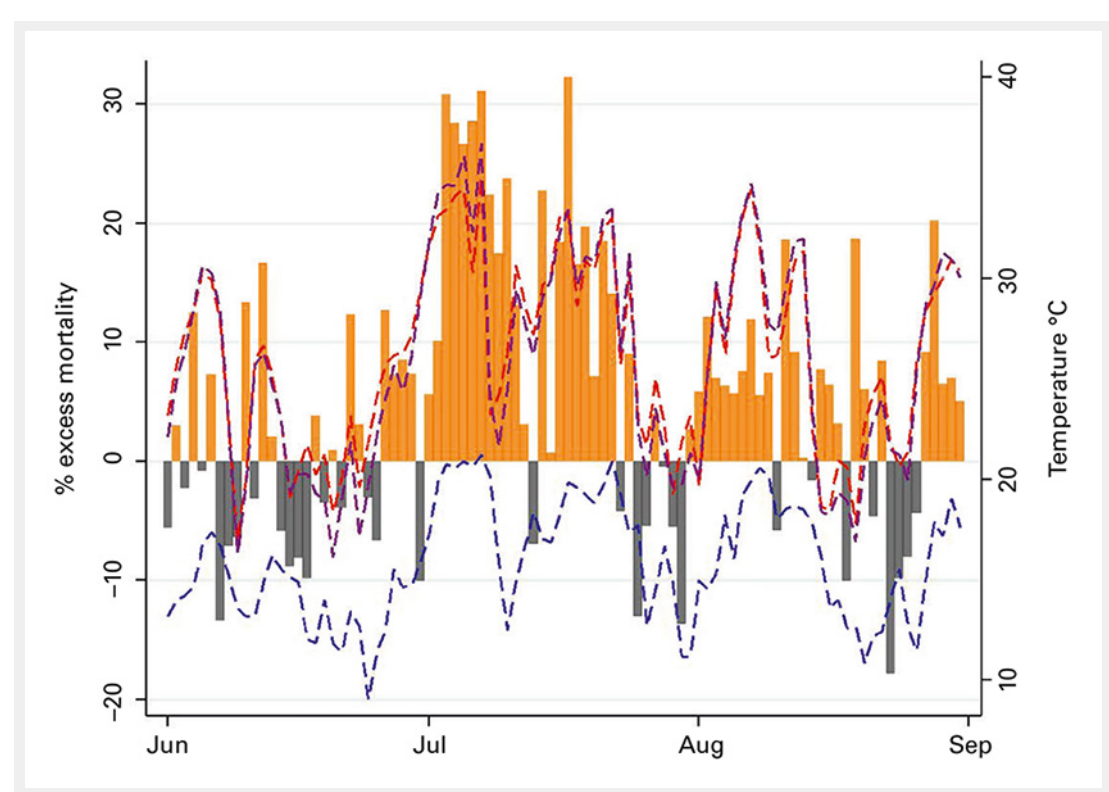
Figure 3 Daily percentage of excess mortality during summer 2015 in Switzerland (vertical bars: orange, positive deviation; grey, negative deviation), and dashed lines showing average daily maximum apparent temperature (purple), maximum daytime (red) and minimum night-time temperatures (blue) across the seven